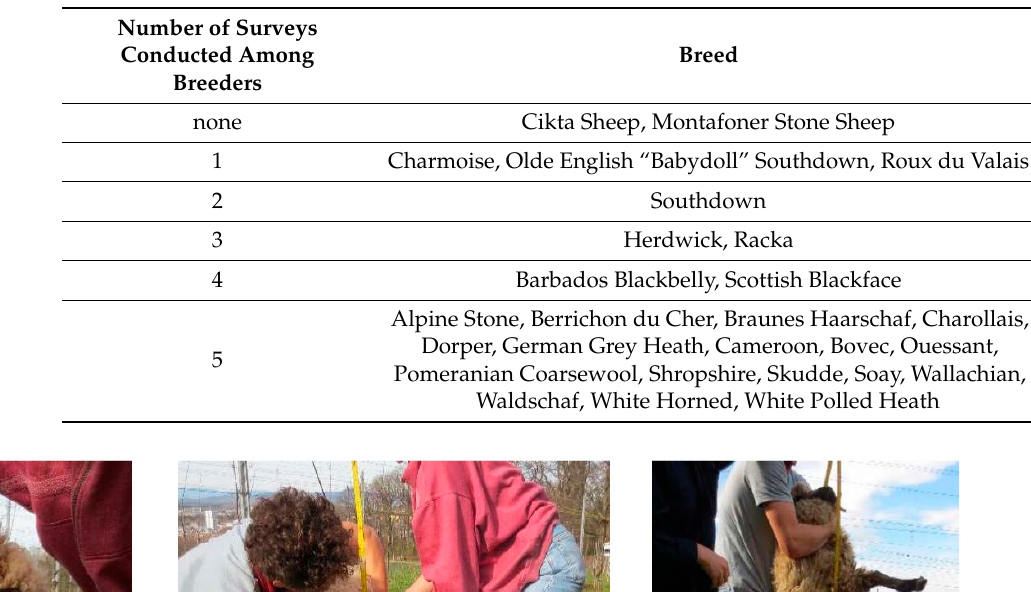
Table 2. The number of surveys of breeders conducted per sheep breed to identify breed-specific suitability for deployment in the vineyard in growing season.